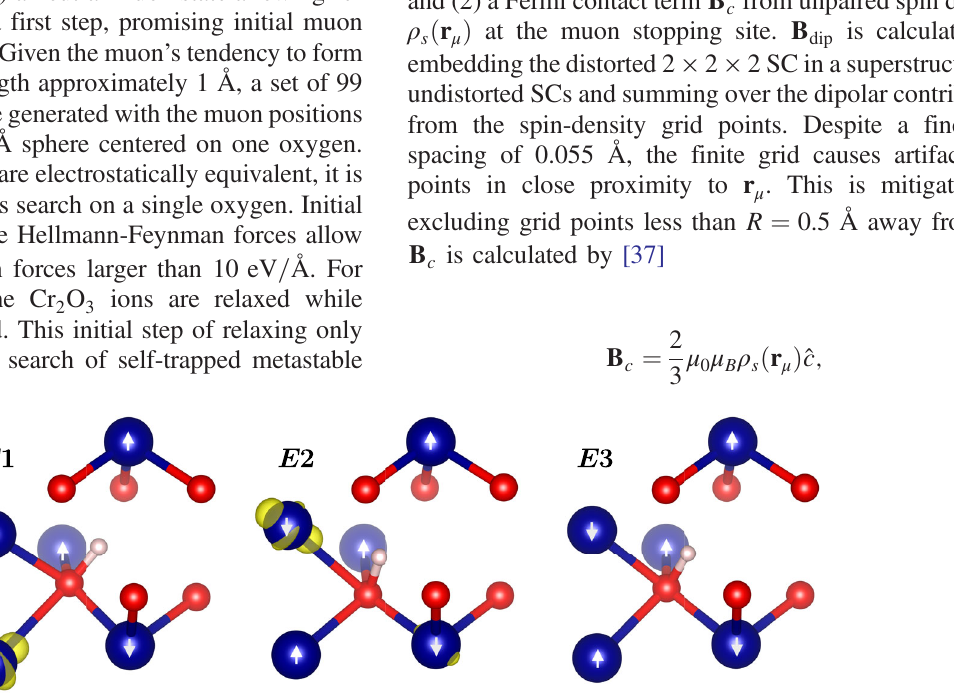
TABLE II. DFT results for various candidate sites and two charge states (CS): dipolar ( f , and angles θ and φ as defined in III B 1. Δ E is the energy relative to the ground state of each charge state, sum of which is given as f tot the spin state of the extra electron for D 1 0 – D 5 0 . Bold rows indicate candidates for E 1 − E 3 . respectively, and d z 2 CS